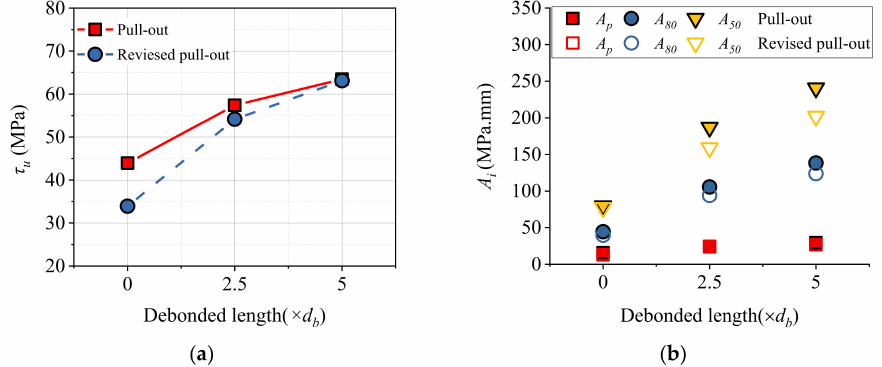
Figure 13. Effect of loading method and debonded length on bond performance: ( a ) bond strength; ( b ) bond toughness.